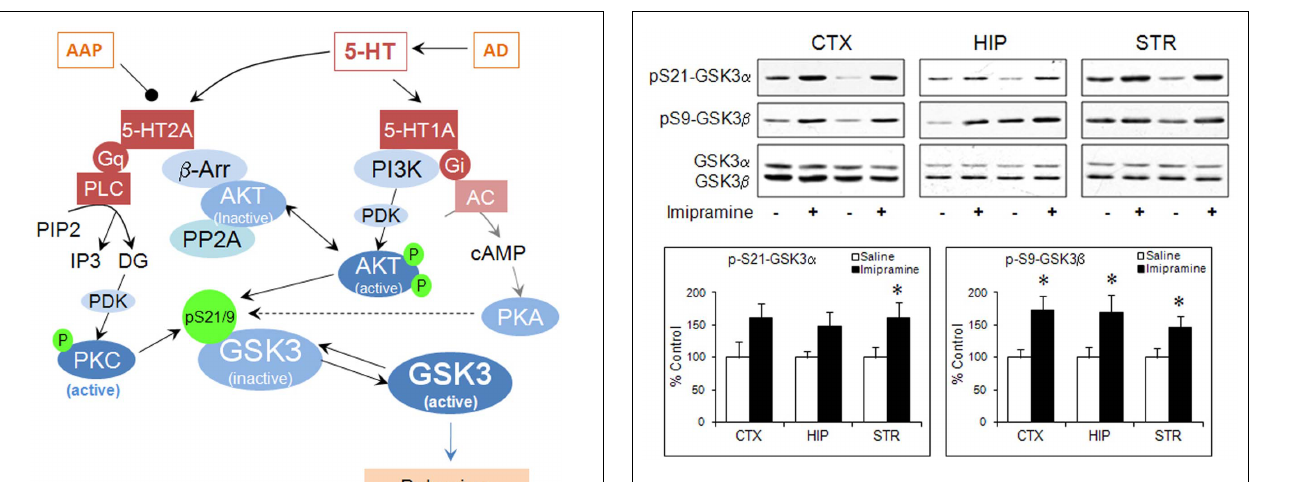
FIGURE 2 | Regulation of phospho-Ser-GSK3 by chronic imipramine treatment in mouse brain. C57BL/6 mice were treated with imipramine (20mg/kg/d, i.p.) for 28days before brain dissection. Homogenates of the cerebral cortex (CTX), hippocampus (HIP), and striatum (STR) were immunoblotted for phospho-Ser21-GSK3 α , phospho-Ser9-GSK3 β , total GSK3 α and total GSK3 β , and data are quantified by densitometry. Protein levels in imipramine-treated samples are calculated as percentage control (saline treatment). Data are mean ± SEM. * p < 0.05 ( n = 7–9 per group) when values are compared to saline treatment in Student’s t